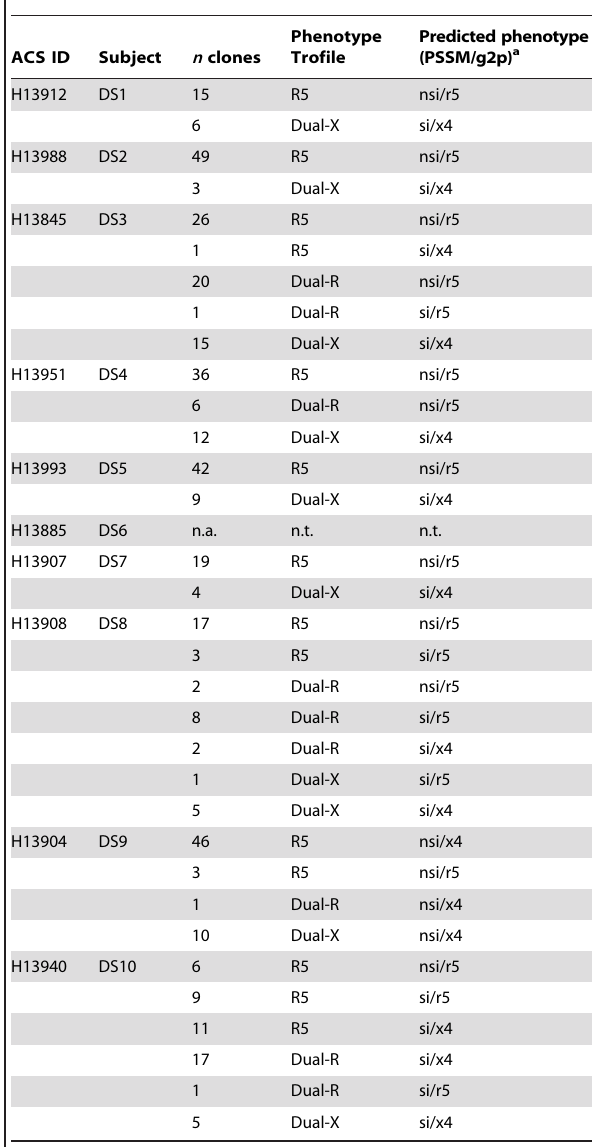
Table 2. CD4 + T cell counts, viral load and MT-2 assay results of participants DS1–DS4 around and during the period of